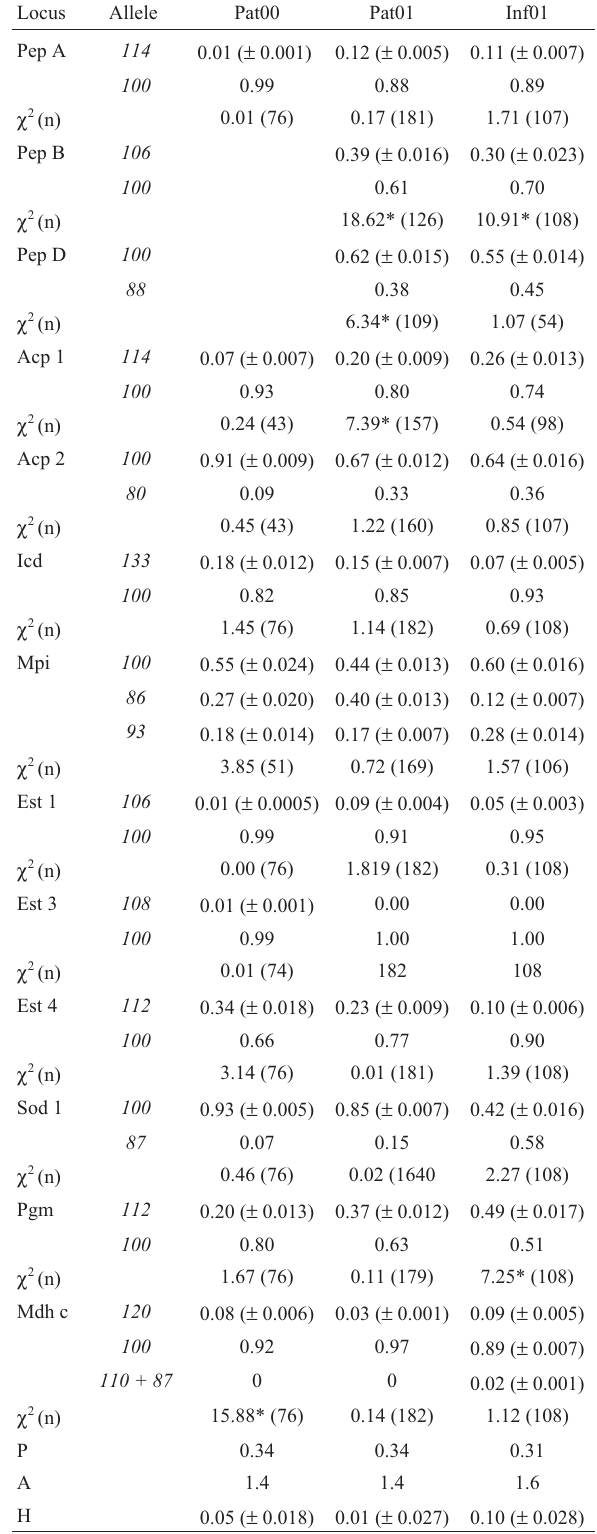
Table 2 - Allele frequencies (standard deviations in parentheses), χ 2 values of genetic equilibrium tests (and number of analyzed individuals in parentheses), proportion of polymorphic loci (P), mean number of alleles (A), and observed average heterozygosity (H) in Digelasinus diversipes